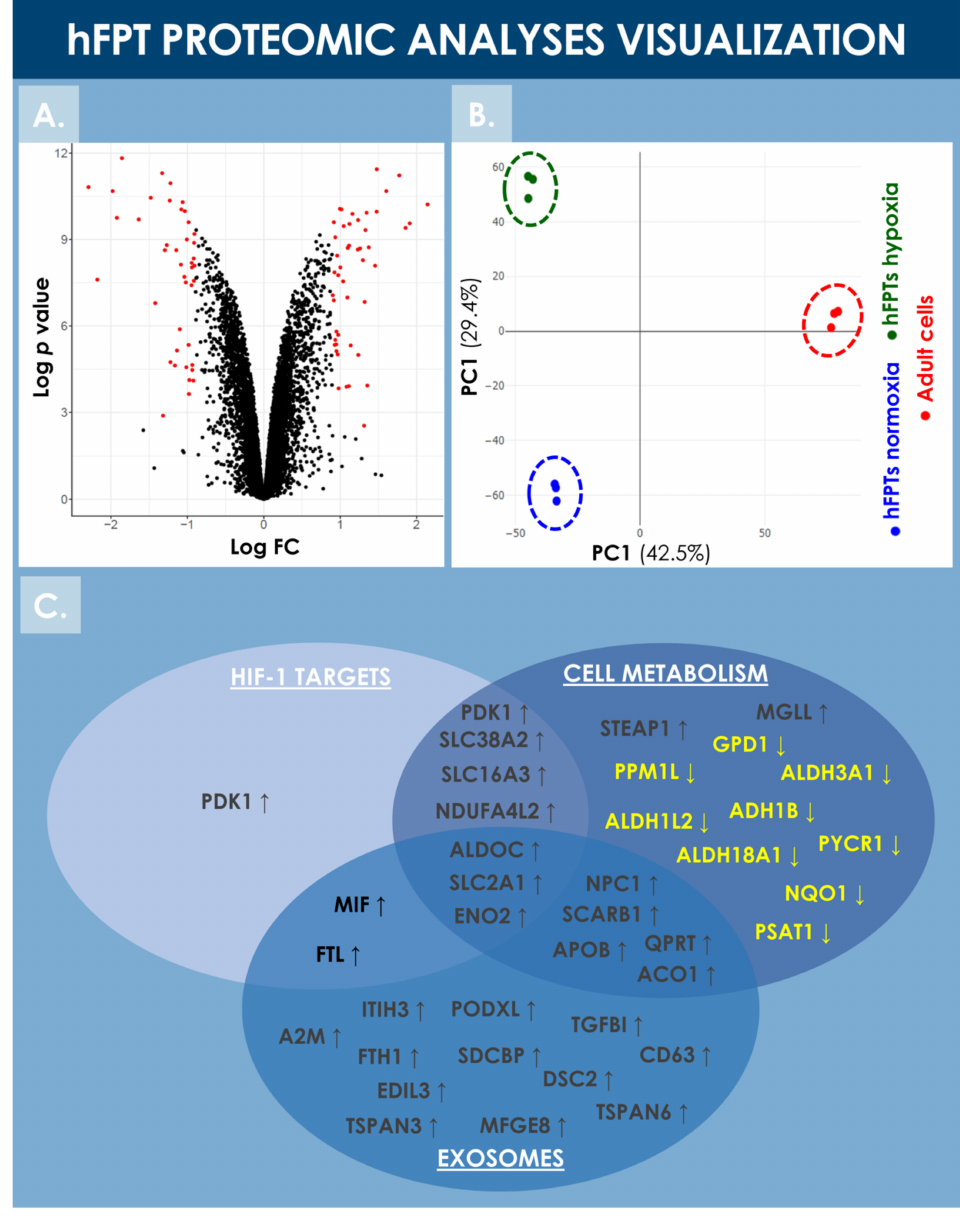
Figure 6. Visualization of the comparative proteomic analyses of hFPTs cultured in hypoxia conditions as compared to hFPTs cultured in normoxia conditions. ( A ) Volcano plot representing the log 2 FC values (i.e., x-axis) assorted to log p -values (i.e., y-axis) of hFPT proteins from the hypoxia sample group as compared to the normoxia sample group. Data points related to protein hits with a significance threshold value specified at − 0.9 for downregulation and at 0.9 for upregulation, and an FDR threshold value specified at ≤ 0.01, are presented in red. ( B ) Principal component analysis biplot representing scores of hFPTs cultured in hypoxia (i.e., green data points) and normoxia (i.e., blue data points) conditions, as well as the scores of adult tenocytes (i.e., red data points) cultured in normoxia and included as controls. ( C ) Venn diagram representing upregulated and downregulated proteins from the hFPT hypoxia sample group as compared to the normoxia hFPT sample group, with regard to respective implications in cellular metabolism mechanisms, exosome production, and hypoxia-responsive mechanisms (e.g., mediated by HIF-1 α ). FC, fold change; FDR, false discovery rate; hFPT, human fetal progenitor tenocytes; PC, principal